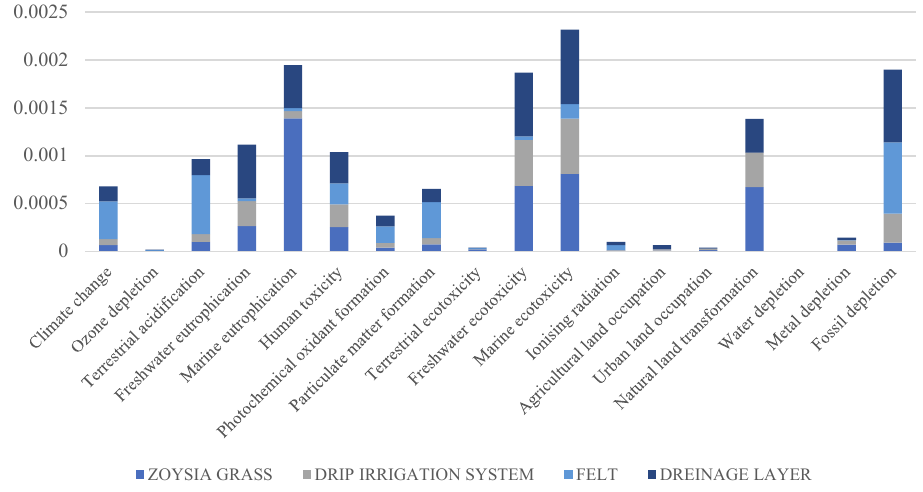
Fig. 3. Normalized Process contribution. Method: ReCiPe Midpoint (H) V1.11 / Europe Recipe H.